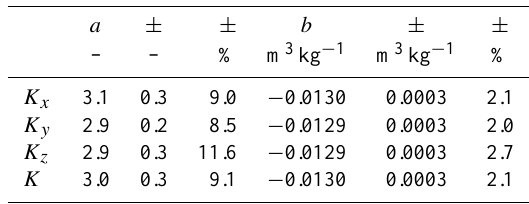
Table 1. Regression parameters ( a and b ) of Eq. (5) for the three components of K , as well as for their mean value K . “Asymptotic standard errors” ( ± ) resulting from the fitting algorithm are given both in absolute units and as percentage